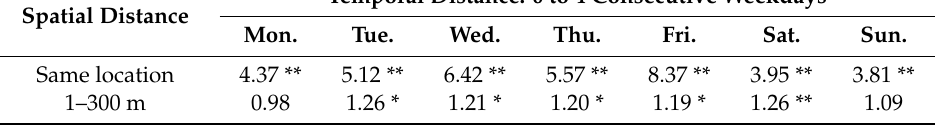
Table 3. Near-repeat risk values (observed over mean expected frequencies) and significance levels of street robbery by weekday. Temporal Distance: 0 to 4 Consecutive Weekdays Spatial Distance Mon. Tue. Wed. Thu. Fri. Sat. Sun. Same location 4.37